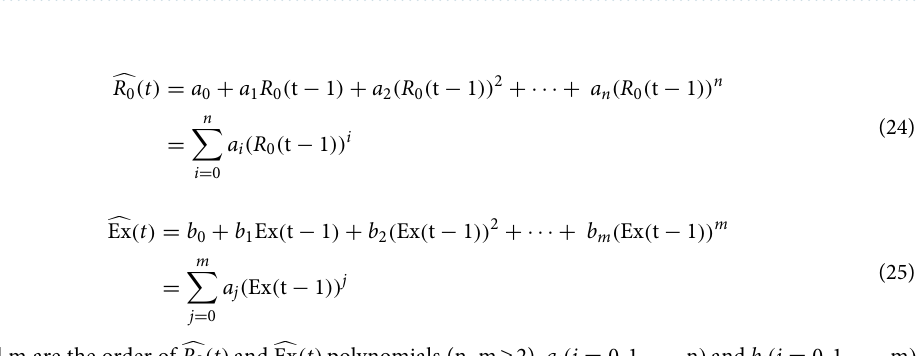
Table 1. COVID-19 data in